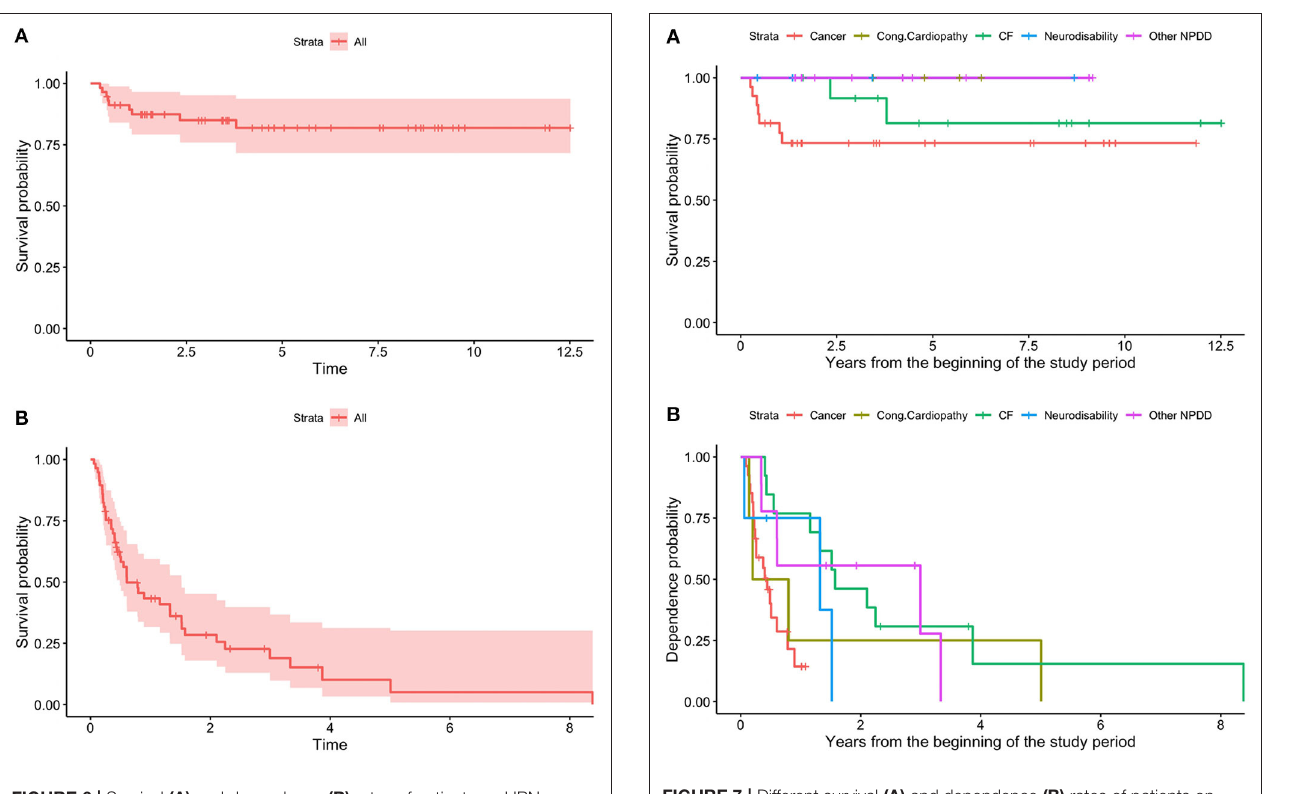
13.9/million in 2010 and 16.6/million at risk in 2012. Also, Goulet